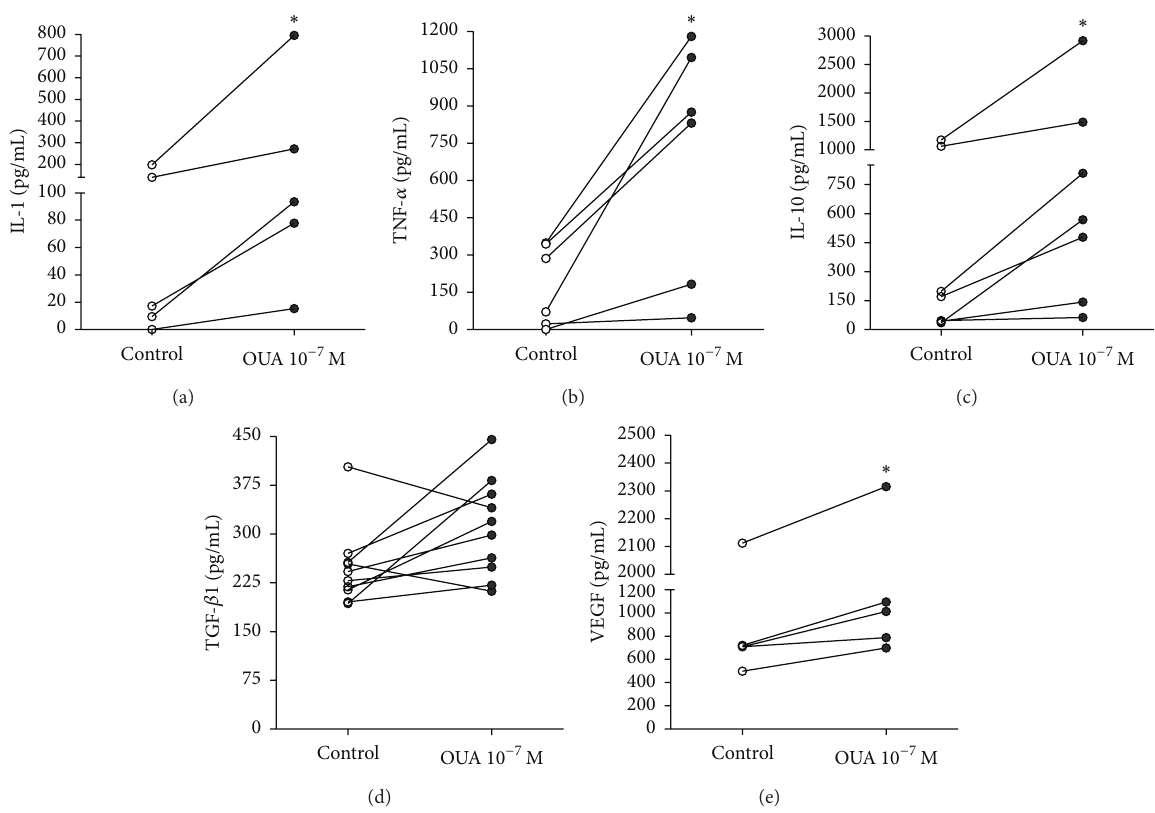
Figure 6: Modulation of cytokine secretion by ouabain. Cells were cultured with 10 −7 M of ouabain for 24 hours or left untreated. Secretion of IL-1 𝛽 , TNF- 𝛼 , IL-10, TGF- 𝛽 1, and VEGF was measured in these culture supernatants by ELISA. Scatter plots indicate the level of IL-1 𝛽 (a), TNF- 𝛼 (b), IL-10 (c), TGF- 𝛽 1 (d), and VEGF (e) measured in pg/mL and each line represents the data from one specific donor. Each condition in all experiments was performed in duplicate. ∗ 𝑃 < 0.05 using Wilcoxon matched pairs test.